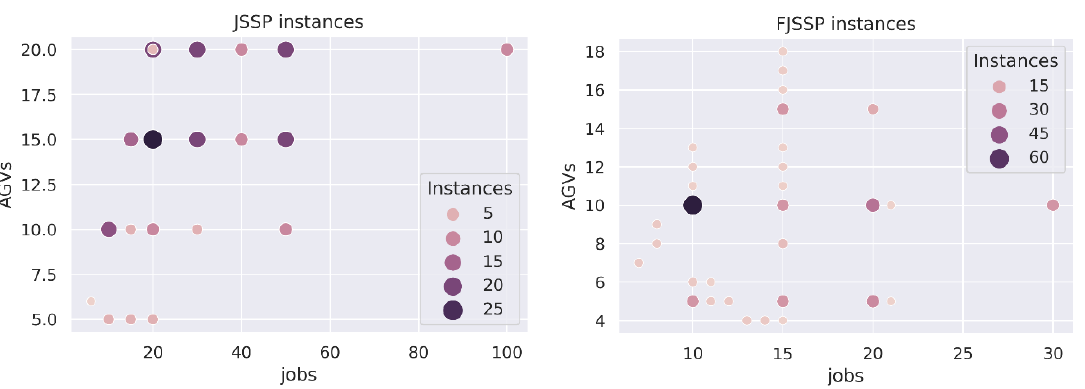
Table 2. Overview of the FJSSP literature benchmark instance collection.